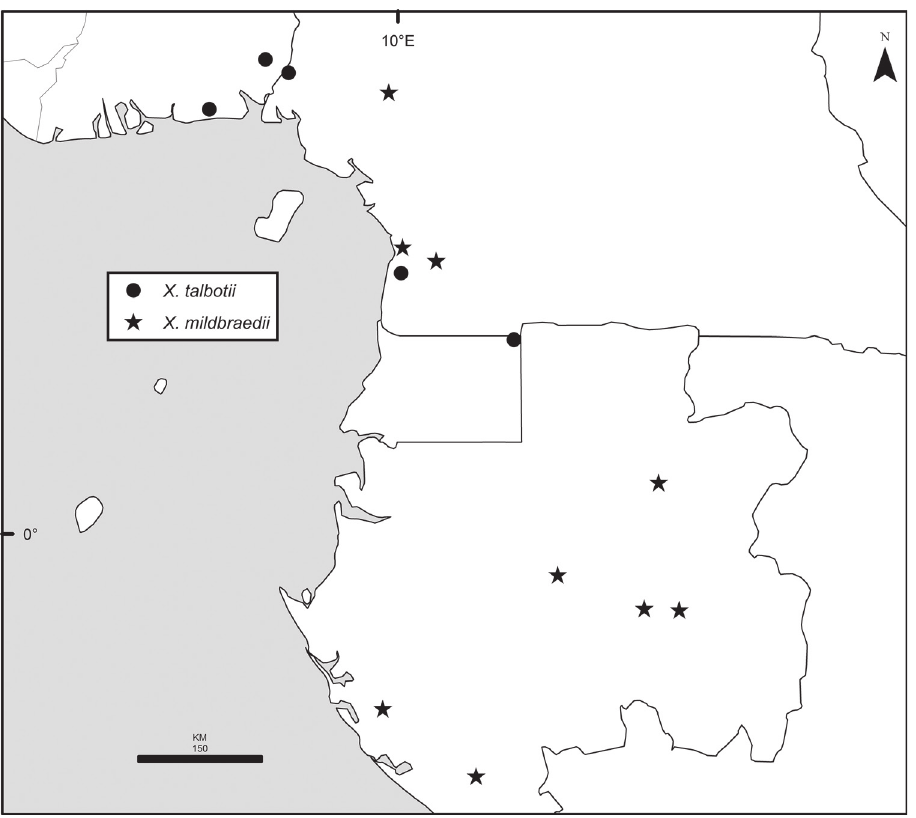
Figure 46. Distributions of Xylopia talbotii and X. mildbraedii . Bolder lines represent country borders, fainter lines lakes and major